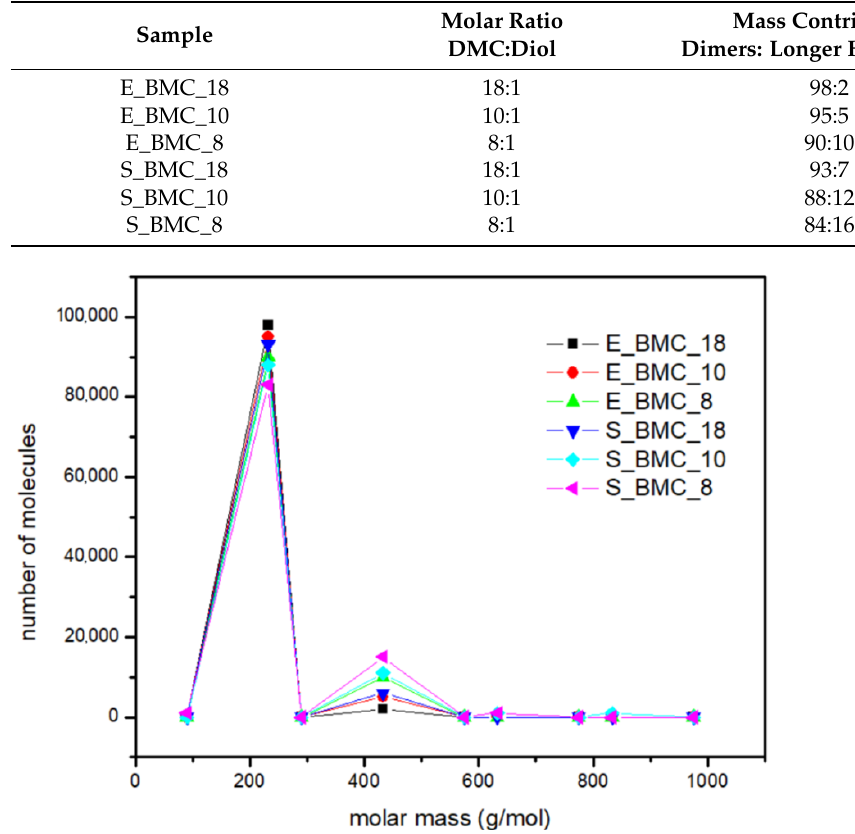
Figure 12. The mass distribution of the BMC: summary of experimental results and simulations for various input parameters.